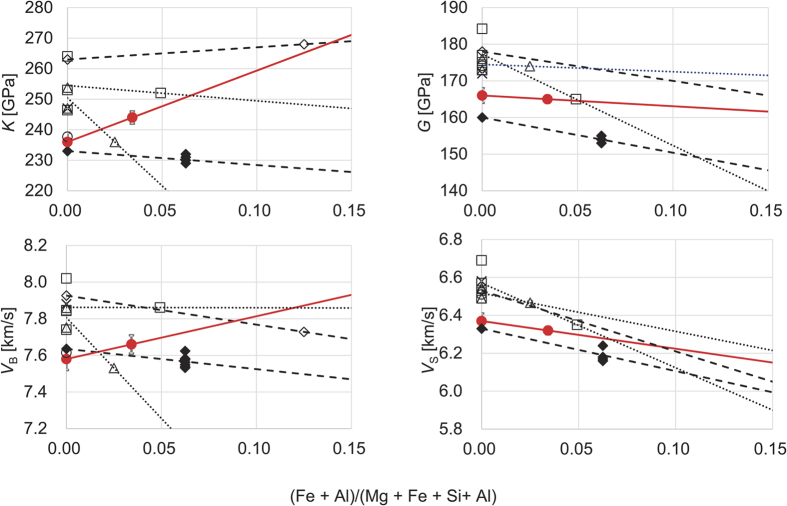
Elastic moduli and elastic velocities of bridgmanite with chemical substitution of Fe and Al for Mg and Si.The present results are shown by solid (red) circles. Open circles, squares, and triangles indicate values determined by RUS20, BLS17181925 and US2159. Diamonds indicate theoretical values (open for ferrous iron (LDA)15 and solid for aluminum and ferric iron (GGA)22). Crosses indicate values by GGA-DFPT-IXS23. Lines are guide for eyes (solid (red): present study; dotted: previous experiments; dashed: theory).